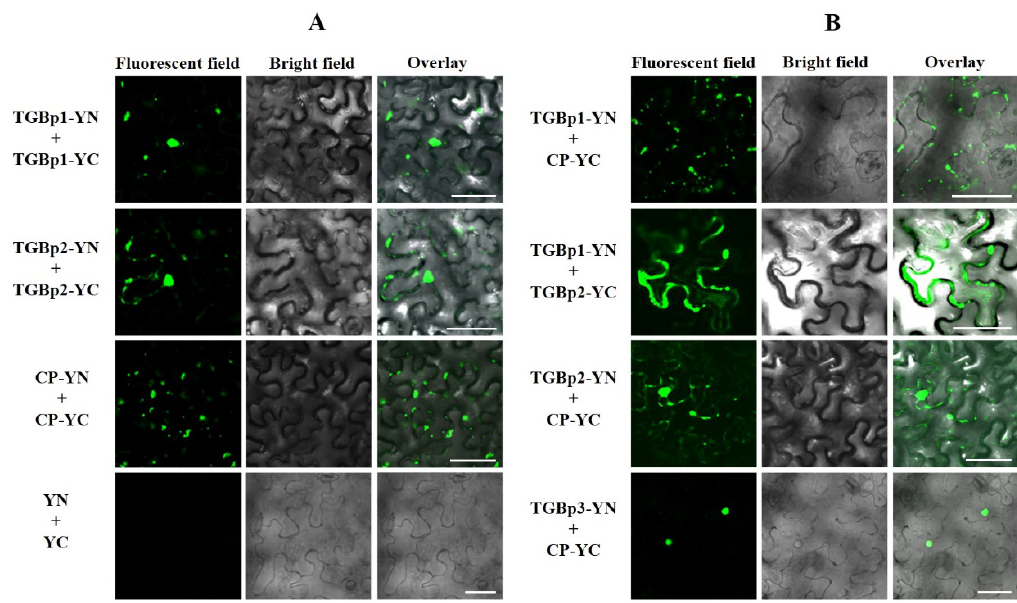
Figure 3. Bimolecular fluorescence (BiFC) assay of the protein-protein interactions of CYVCV in N. benthamiana epidermal cells. ( A ) Homologous interactions of CYVCV proteins TGBp1, TGBp2, and CP. ( B ) Heterogonous interactions of paired CYVCV proteins. The proteins were transiently coexpressed with recombinant vectors of BiFC (nYFP and cYFP) in N. benthamiana epidermal cells and visualized under confocal microscopy. YN and YC represent the C-terminus and N-terminus of YFP, respectively. The negative control with complementary empty vector tags is shown as “YN + YC”. Bar = 20 µm.